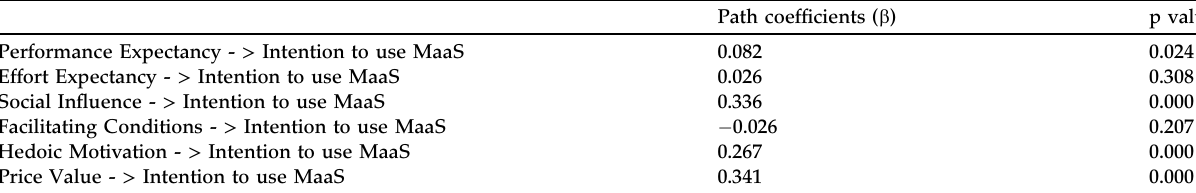
Table 3. Estimates of standardized path coef fi cients.